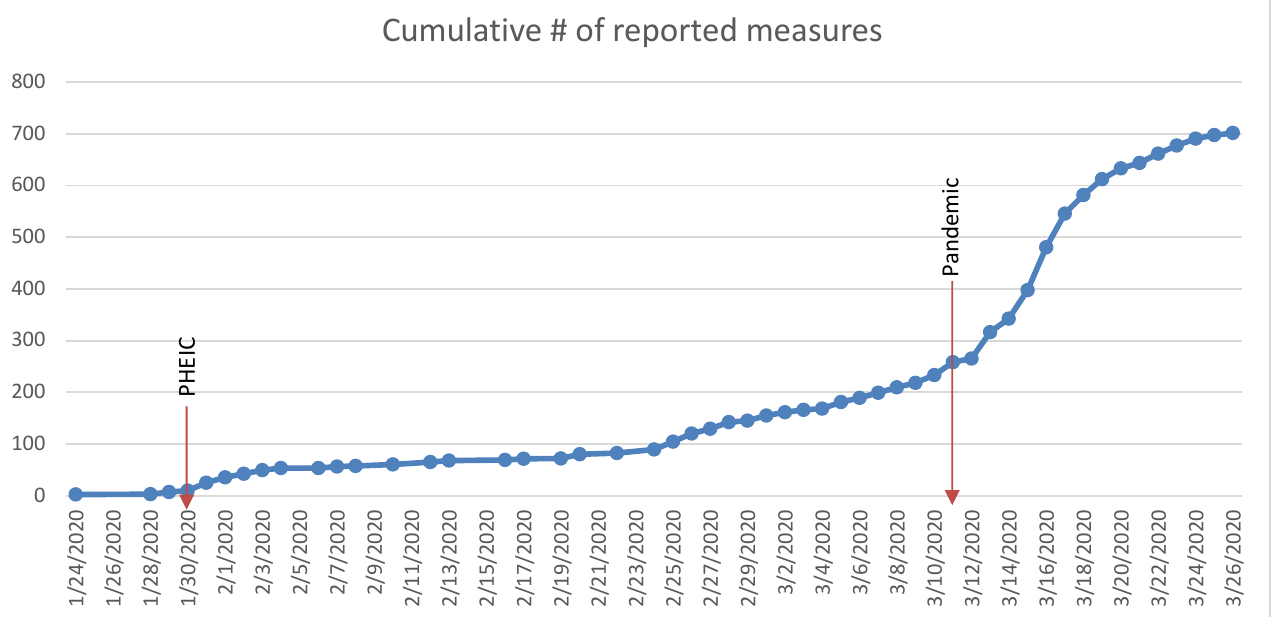
Figure 1. Cumulative number of reported additional health measures